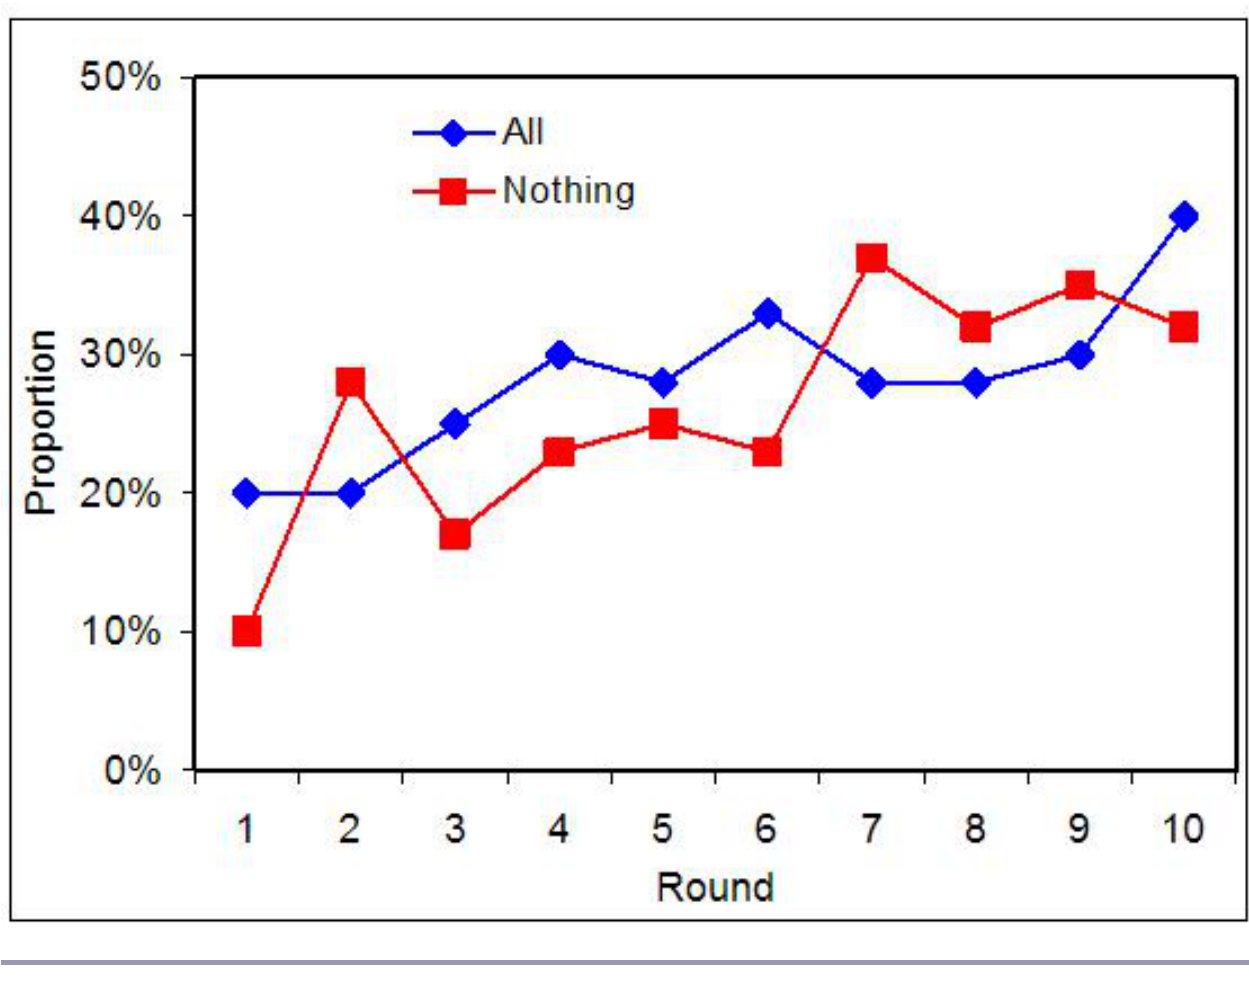
Fig. 3 . Increasing variance across players over time in a public-good experiment with marginal per capita return equal to 0.3 and group size equal to 40. There seem to be a bifurcation within the population of those who invested everything and those who invested nothing in the public